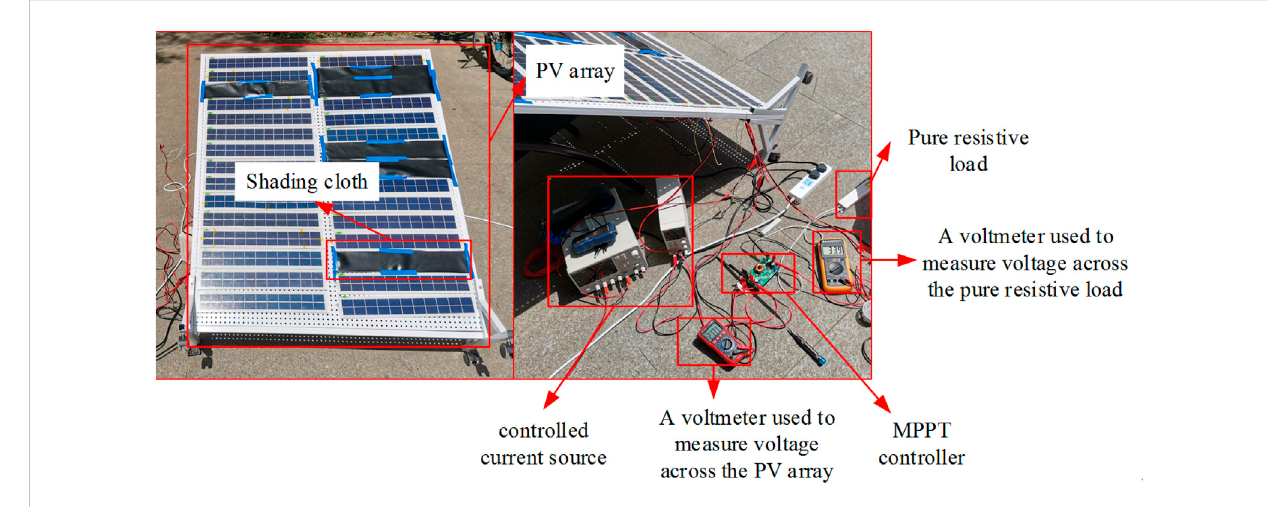
FIGURE 9 Real shooting of